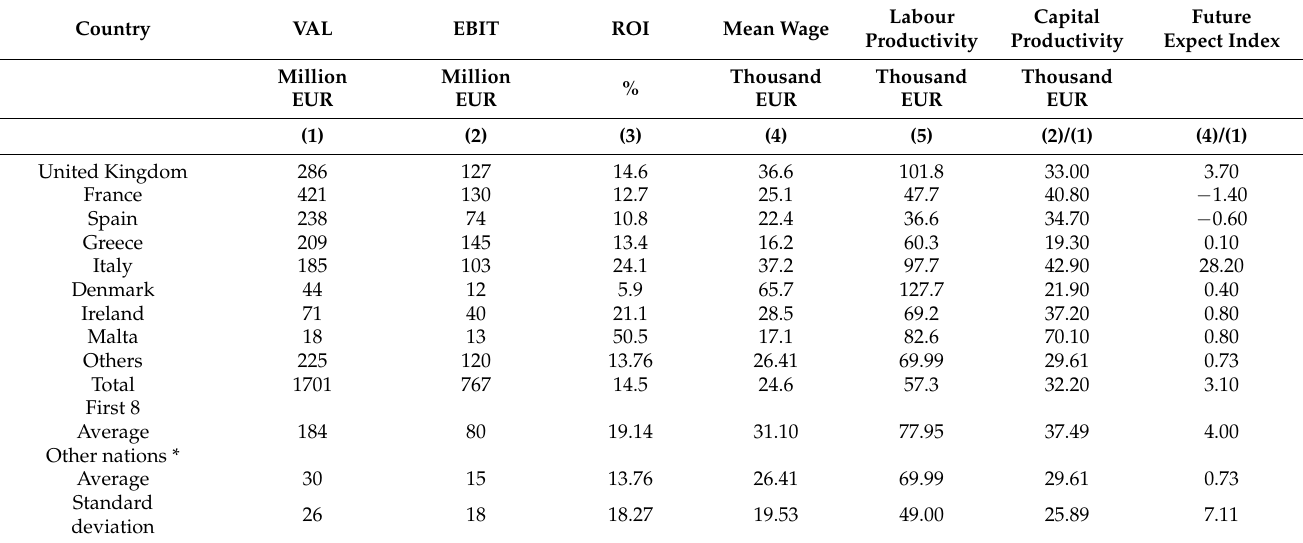
Table 11. Economic indicators of the aquaculture industry country’s structure in the EU and ra- tio